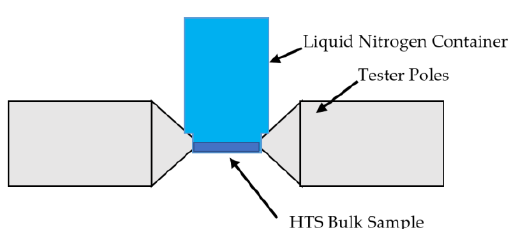
Figure 1. Tester arrangement incorporating the HTS bulk sample is placed inside the liquid nitrogen box.